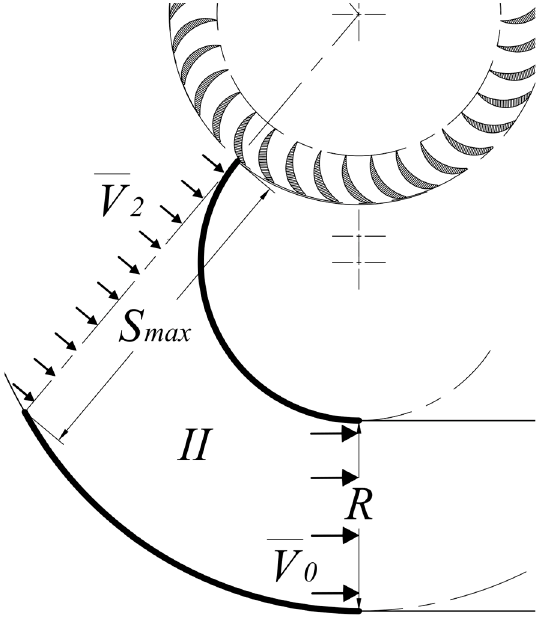
Figure 7. Section view of the second diffuser part.